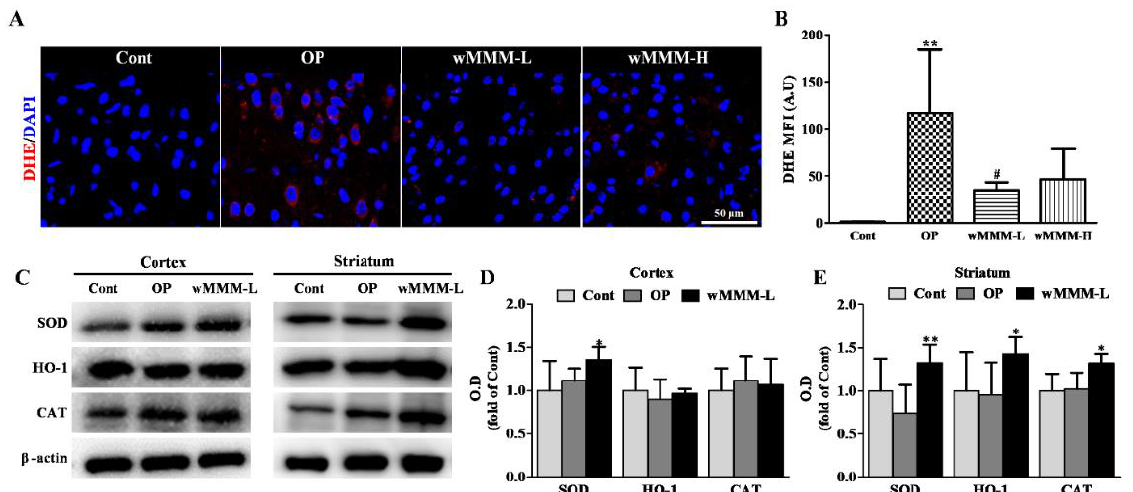
Figure 7. Antioxidant effects of water extracts of mixed mushroom mycelia (wMMM) on an in vivo focal cerebral ischemia (fCI) model. Representative images ( A ) of a DHE-stained fCI cortical lesion and the quantitative graph ( B ) showing the mean fluorescence intensity of DHE were presented. In ( A ), 4 (cid:48) ,6-diamidino-2-phenylindole (DAPI) was used to stain nuclei. In ( B ), data are presented as the mean ± standard deviation (** p < 0.01 vs. Cont; # p < 0.05 vs. OP; n per group = 2). ( C ) Representative Western blot images showing the amount of SOD, HO-1, and CAT in the ischemic cortex or striatum homogenates and the corresponding bar graphs ( D , E , respectively). For the quantifications in ( D , E ), the optical density was normalized by β -actin. In ( D , E ), data are presented as the mean ± standard deviation (* p < 0.05 and ** p < 0.01 vs. OP; n per group = 4). In all graphs, significance was determined by one-way ANOVA followed by a Tukey post hoc test for pairwise comparisons. DHE, dihydroethidium; A.U, arbitrary unit; SOD, Superoxide dismutase; HO-1, heme oxygenase-1; CAT, Catalase; Cont, control group; OP, the group with vehicle and middle cerebral artery occlusion and reperfusion (MCAO/R); wMMM-L, the group with low dose (30 mg/kg) of wMMM and MCAO/R; wMMM-H, the group with high dose (90 mg/kg) of wMMM and